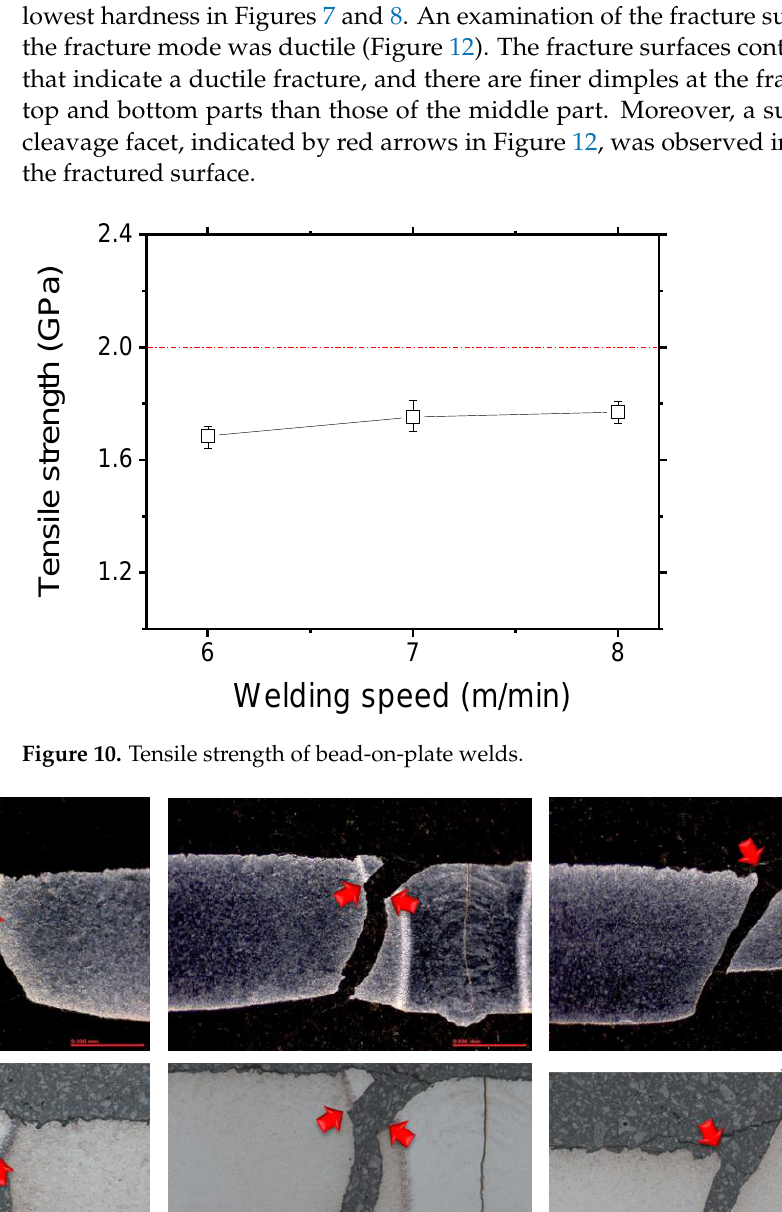
Figure 11. Fractured specimens after tensile test.